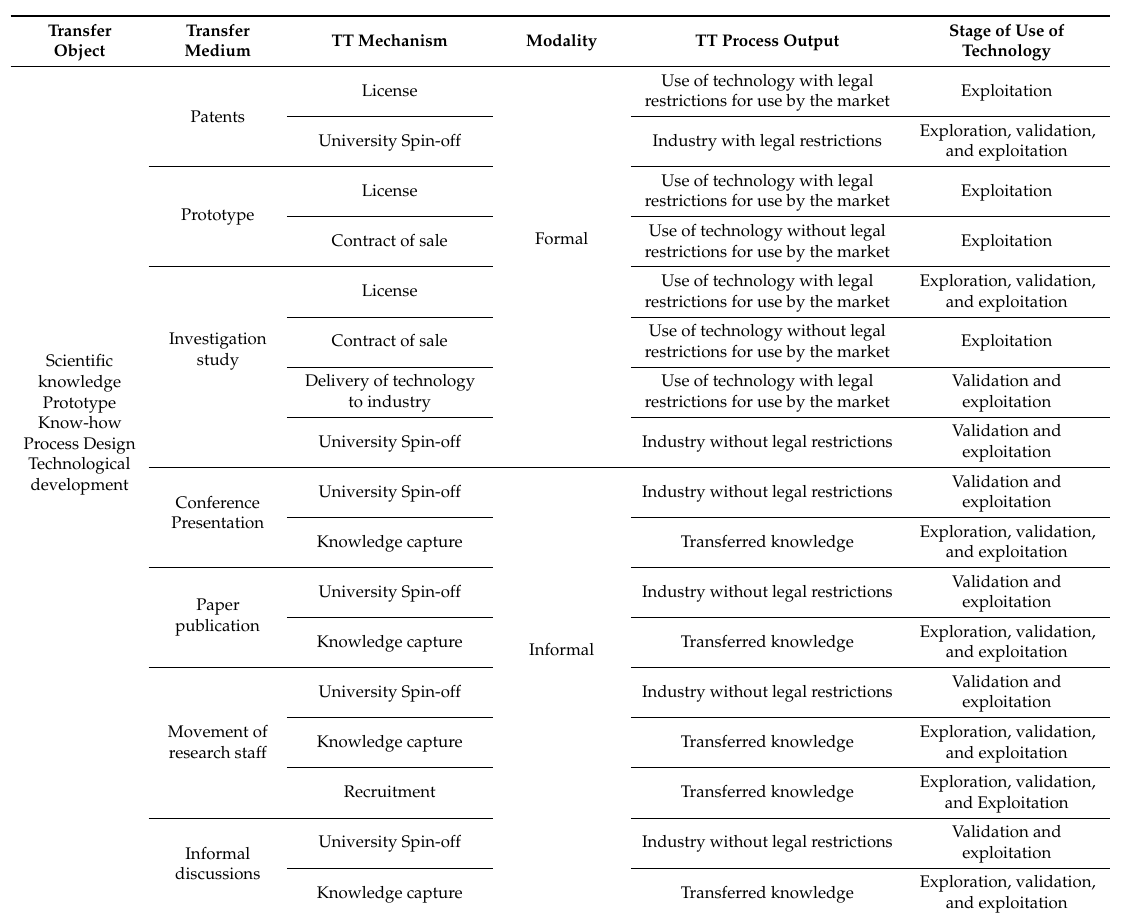
Table 2. List of elements of a